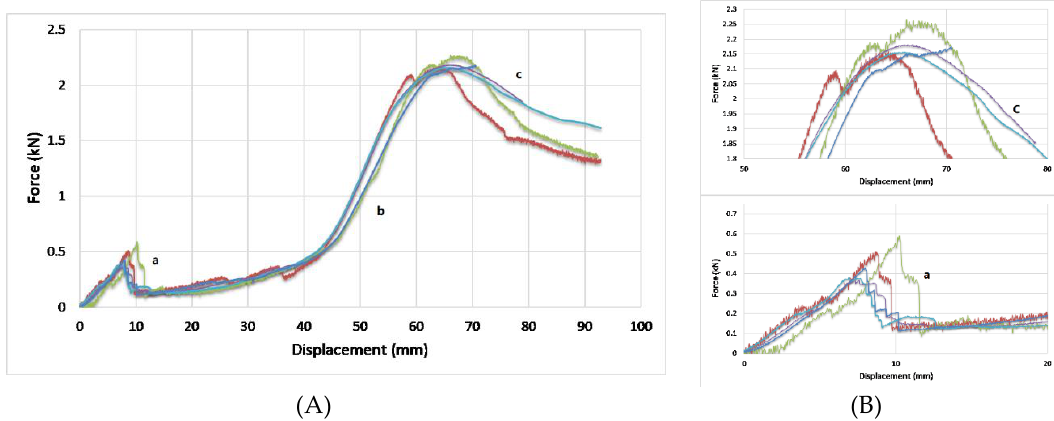
Figure 6. Force–displacement diagrams of specimens: ( A ) whole trend and ( B ) details showing the proportional response zone ( a ), the bottleneck completely dented ( b ) and final buckling ( c ).